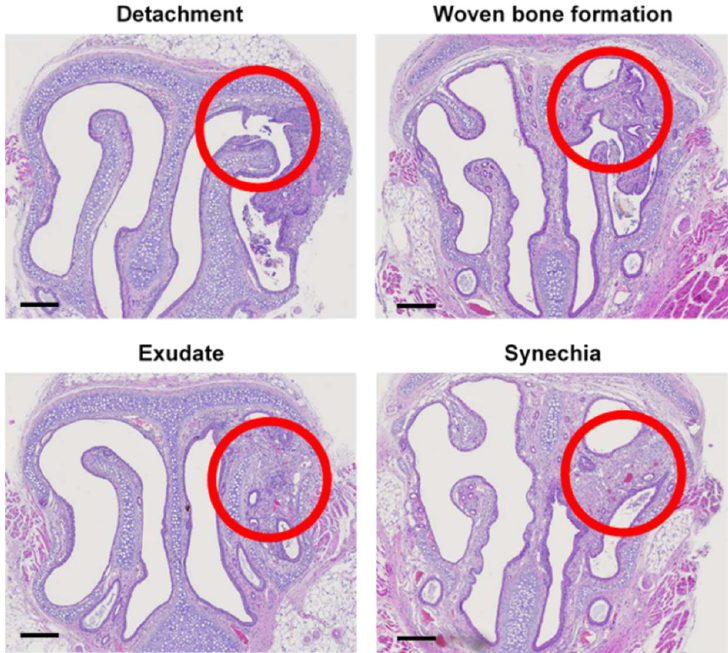
Figure 4. Representative H&E-stained images of sinonasal cavity treated after the mechanical injury of mucosa in mice. The mucosal detachment, woven bone formation, exudate and synechia were indicated as circles. The scale bar represents 500 μm.